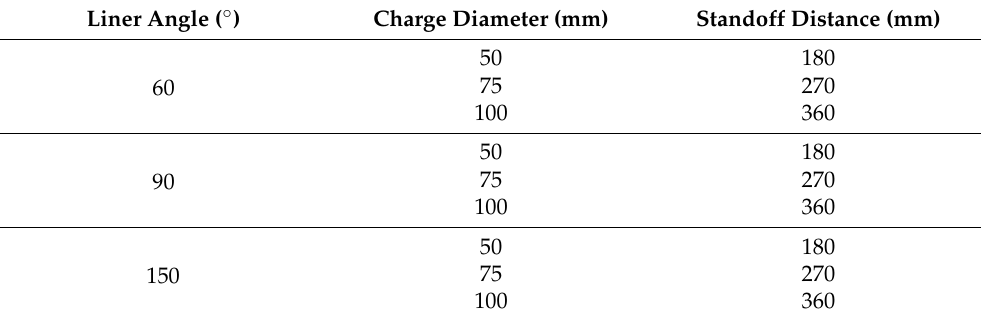
Table 6. Simulation scenarios.